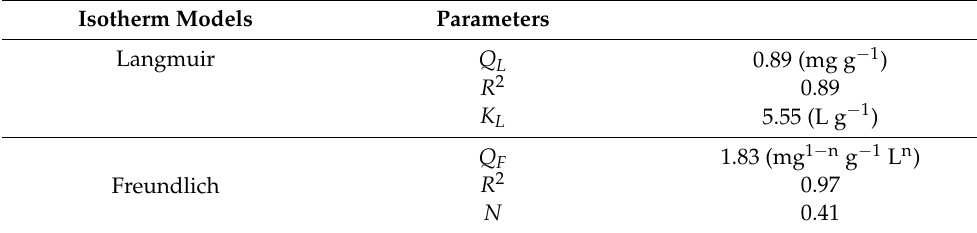
Table 2. Equilibrium isotherm modeling data of As(V) adsorption on egg shell biochar. Isotherm